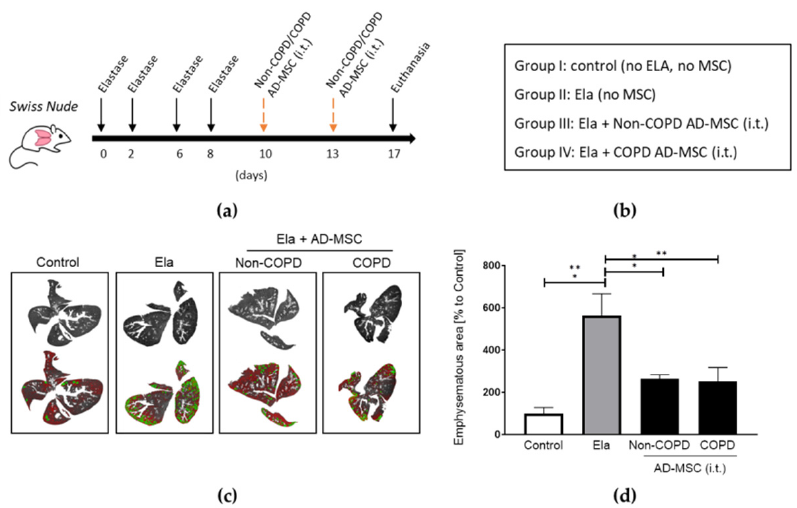
Figure 2. Human AD-MSC derived from COPD patients were equally efficient as those from non- COPD in reducing elastase-induced lung emphysema. ( a ) Timeline in days of the elastase and MSC treatments, and ( b ) groups of treatments included. ( c ) Digital evaluation of emphysematous areas of the lungs and ( d ) quantification and statistics. Treatments were performed intratracheally (i.t.). n =